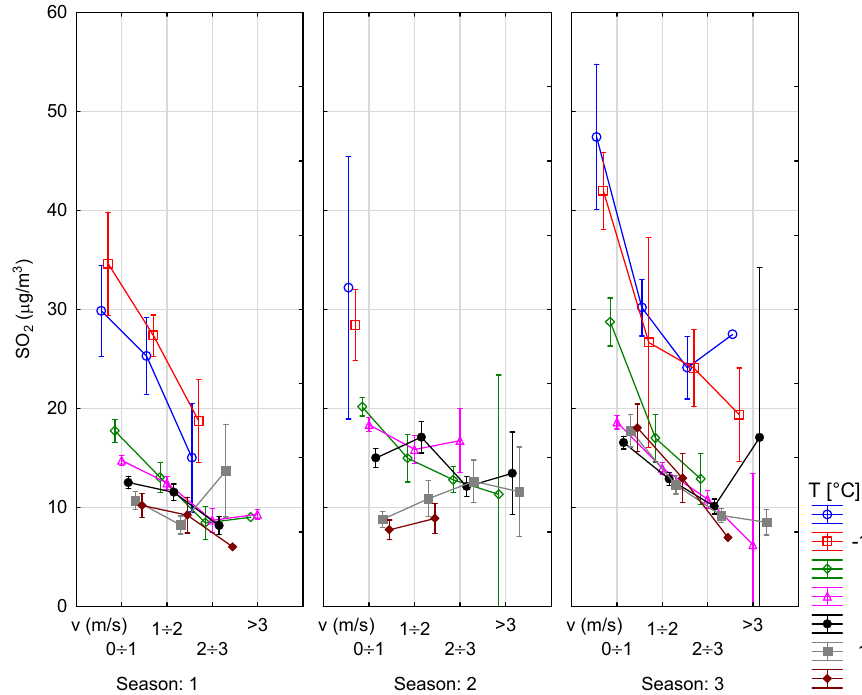
Figure 9. Relation between SO 2 concentration, temperature and wind speed.